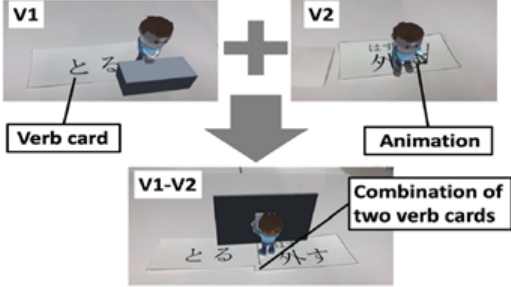
Figure 3: A system for studying complex verbs consisting of one or more Kanji characters, based on AR [11].